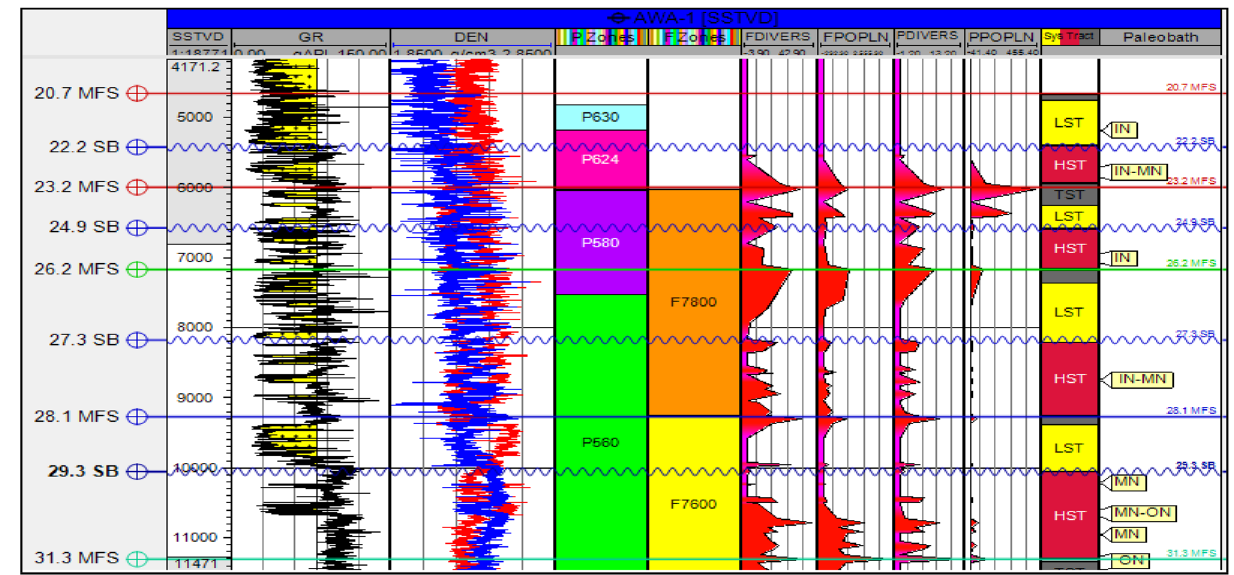
Fig. 3 Sequence stratigraphic tops interpretation using MFSs, SBs picked using gamma ray log, resistivity log, palynological and foraminiferal zones, pollen and forams diversity and population on Awa-1 well